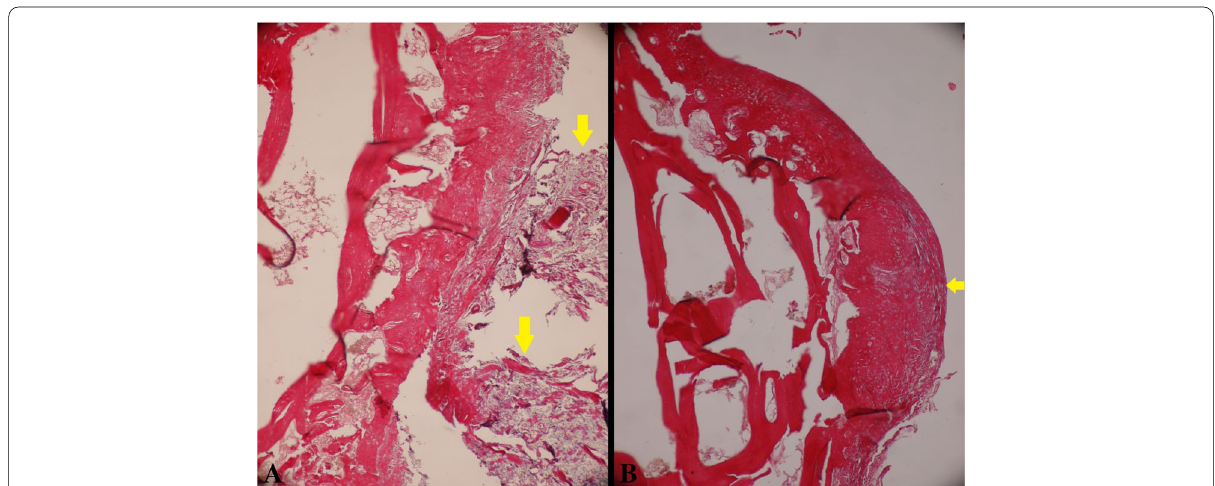
Fig. 2 A Control group with marked arthrofibrosis and deposition of collagen bundles in articular surface (yellow arrow); B Treatment group with captopril, the collagen deposition is less obvious ( ×